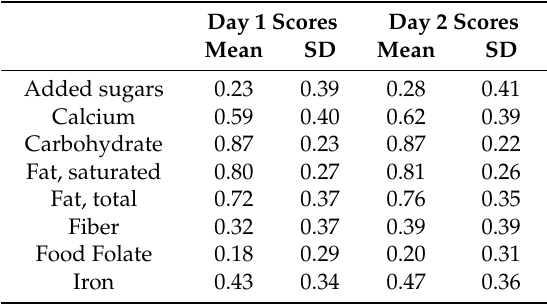
Table 2. NNA scores (individual nutrients and total score) for non-pregnant women aged 31–50 years, energy intake of 1700–2300 kcal ( n = 1348).